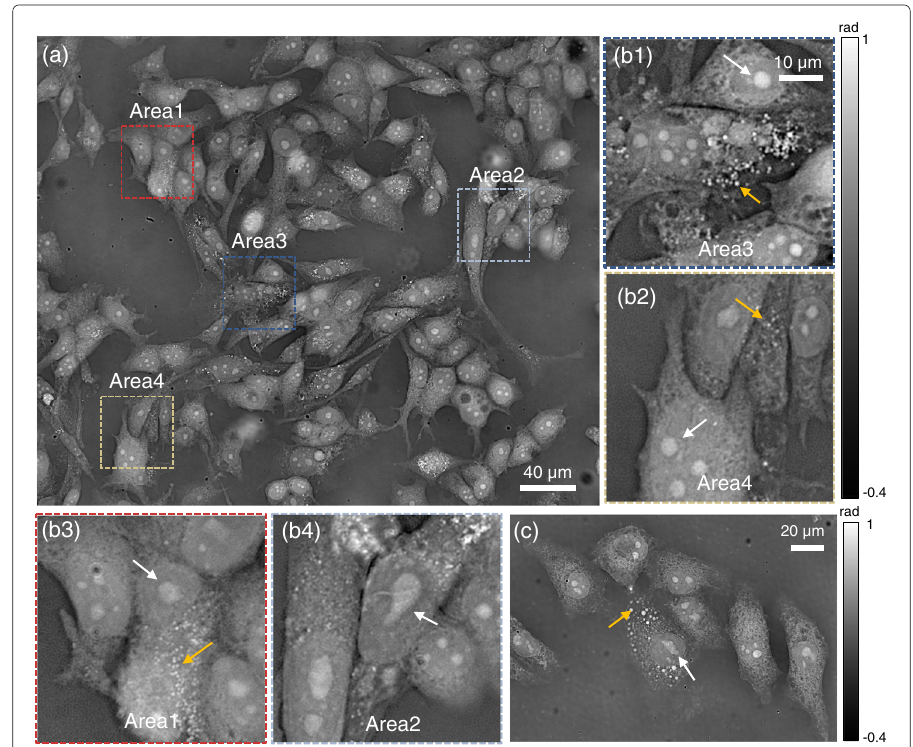
Fig. 18 The reconstructed quantitative phase of unstained MCF-7 Breast Cancer Cell and HepG2 living carcinoma cells. (a) Full FOV quantitative phase image of MCF-7 cell. (b1)-(b4) Enlarged images of the sub-region of interest in the red, wathet, blue, and yellow boxes. (c) The reconstructed quantitative phase of HepG2